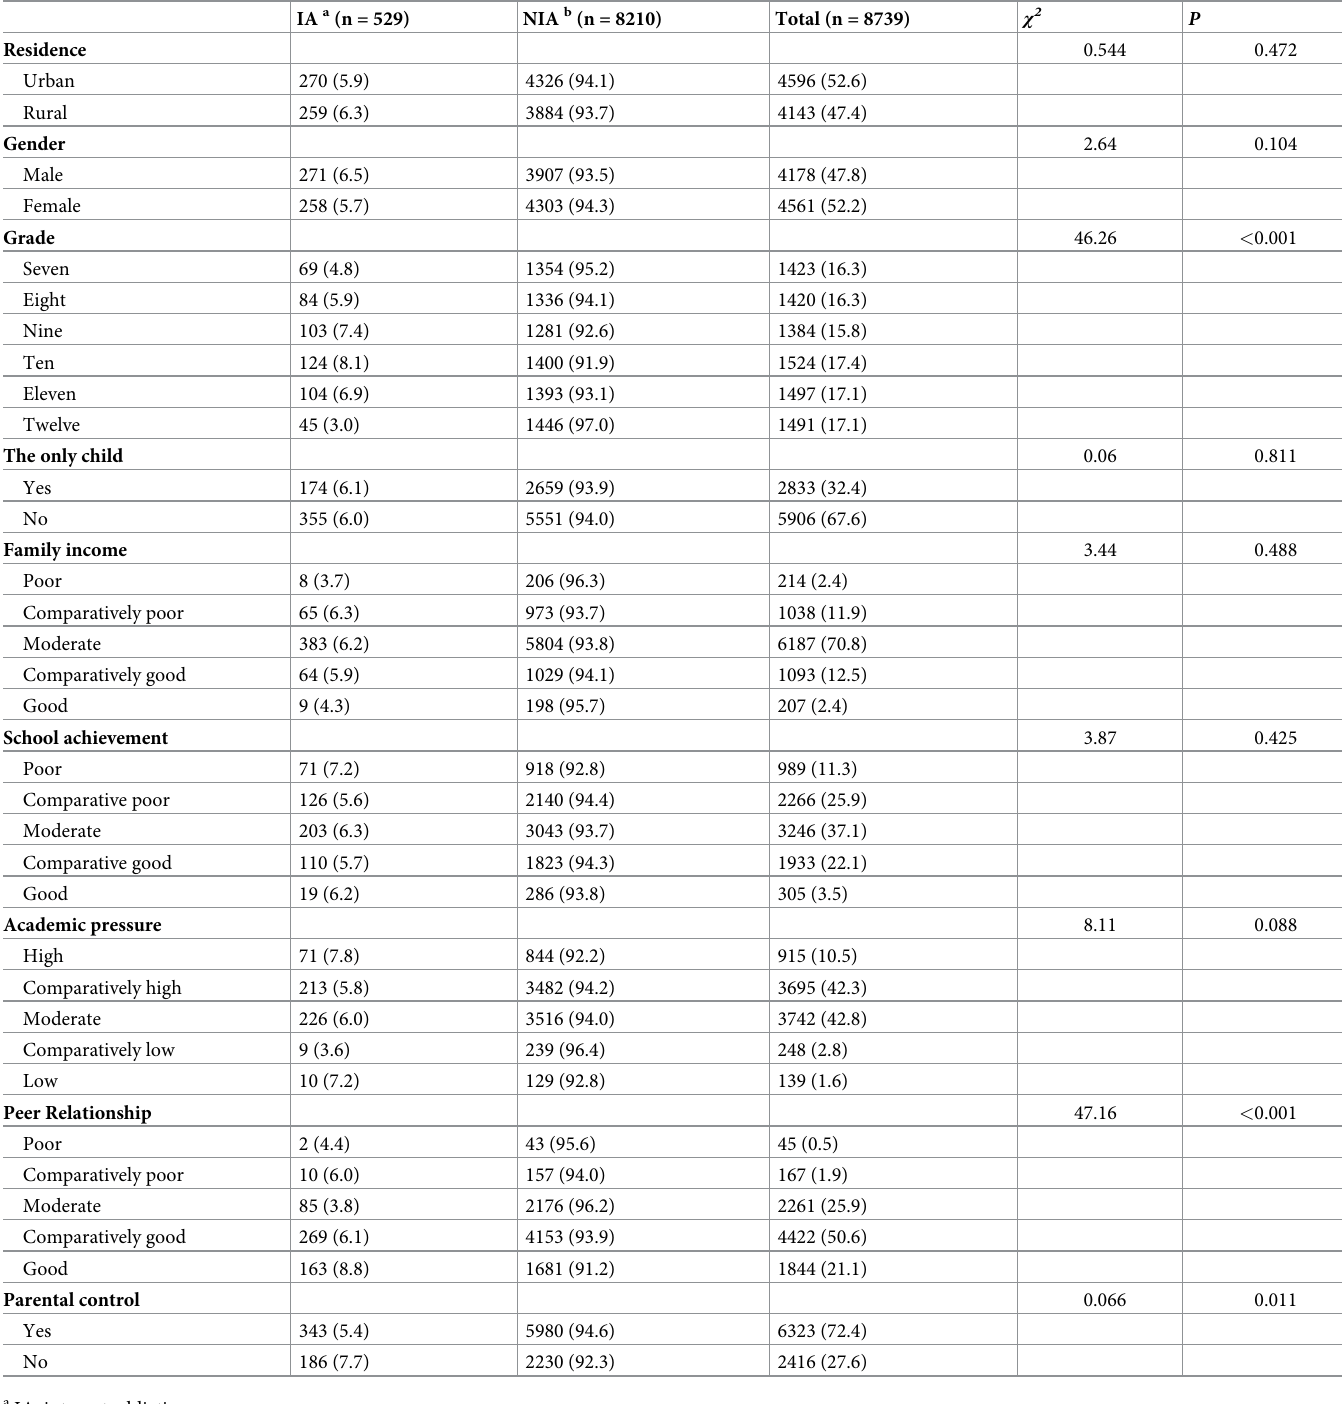
Table 1. Distribution of sociodemographic characteristics between the internet addiction group and the noninternet addiction group (n =